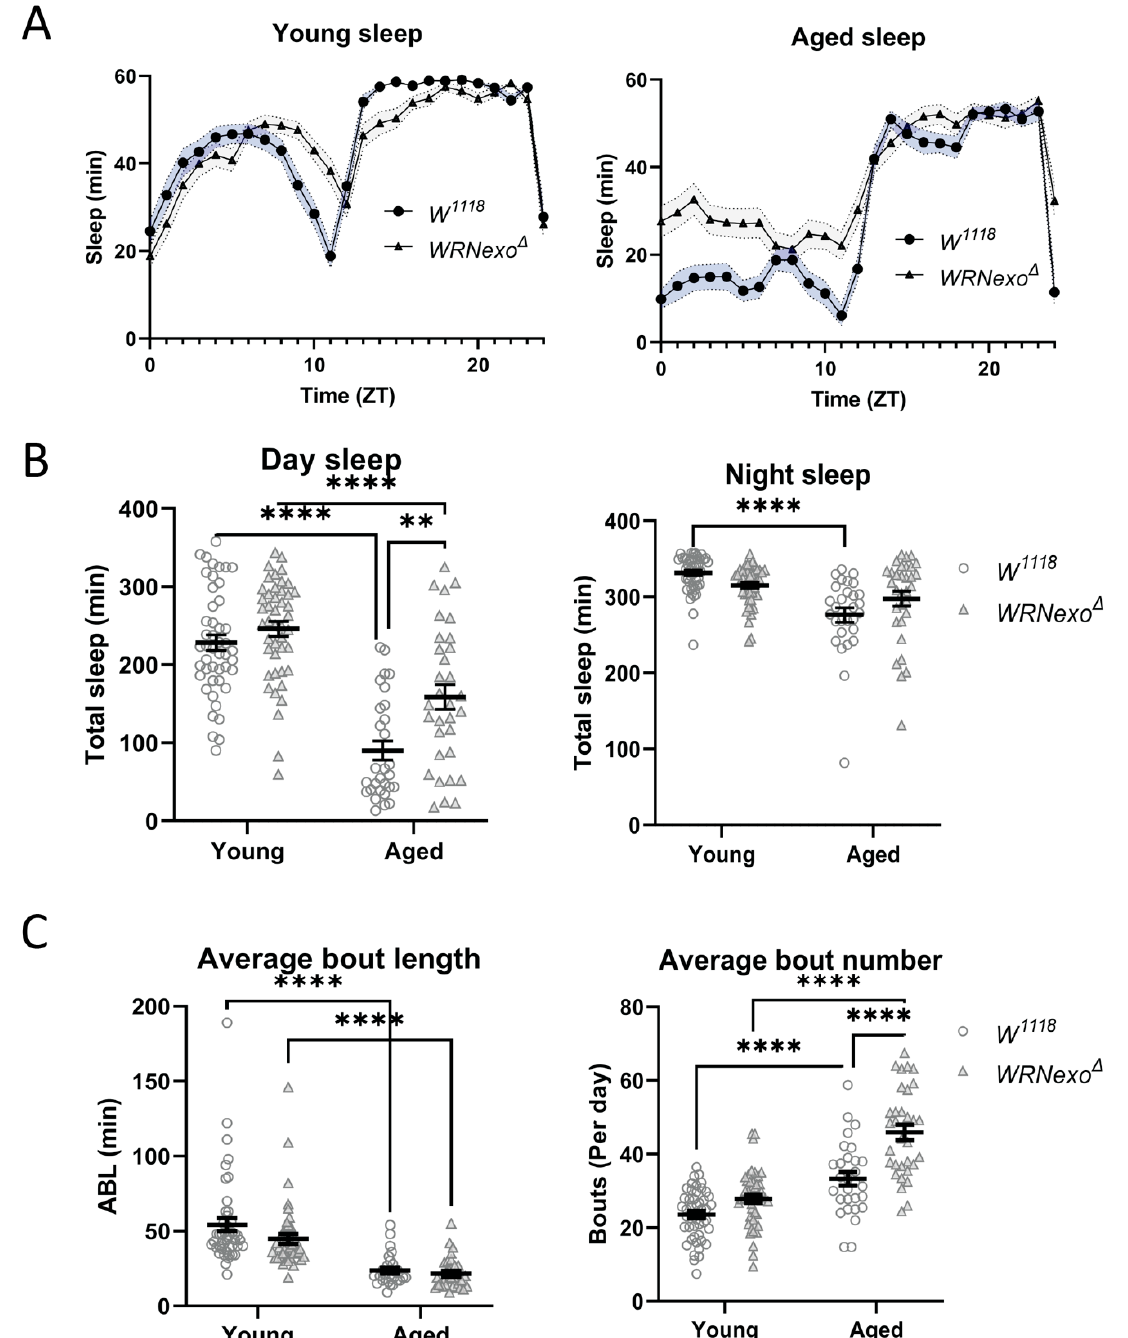
Figure 4. WRNexo ∆ display age-dependent differences in total sleep and composition. ( A ) Young w 1118 and WRNexo ∆ flies exhibit similar levels of sleep throughout the day, while aged WRNexo ∆ flies exhibit greater sleep during the light phase compared to aged w 1118 controls. ( B ) Both aged w 1118 and WRNexo ∆ flies exhibit decreased sleep during the day compared to young flies and aged WRNexo ∆ flies display greater sleep than age-matched w 1118 . ( C ) Aged WRNexo ∆ show greater sleep fragmentation compared to w 1118 flies. While WRNexo ∆ and w 1118 exhibit similar average bout length in both young and aged flies, aged WRNexo ∆ exhibit significantly greater bouts per day compared to age matched w 1118 controls. (2-way ANOVA, ** p < 0.01, **** p < 0.0001, ±SD).